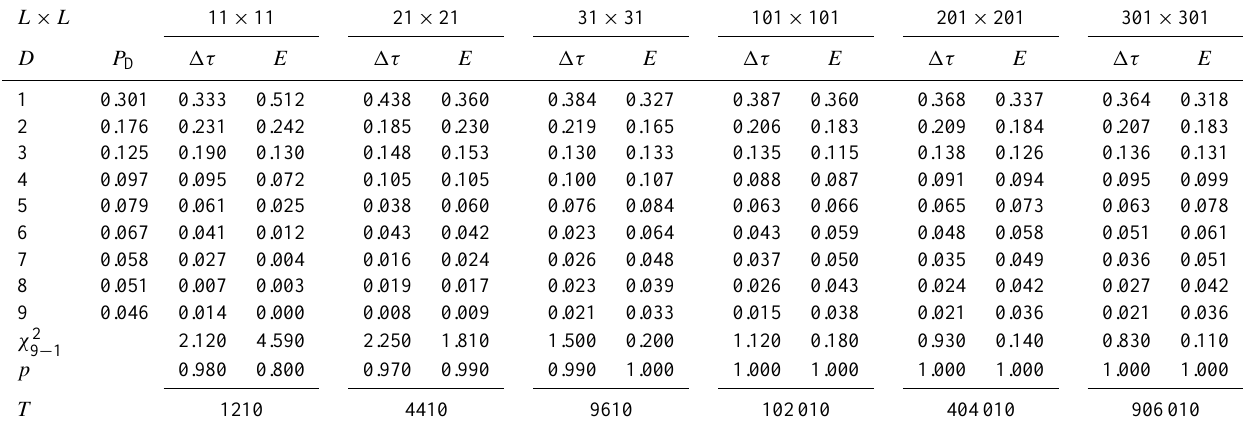
Table 3. BTW two-dimensional cellular automaton (Bak et al., 1987, 1988). First digit statistics for various two-dimensional cellular au- tomata of different